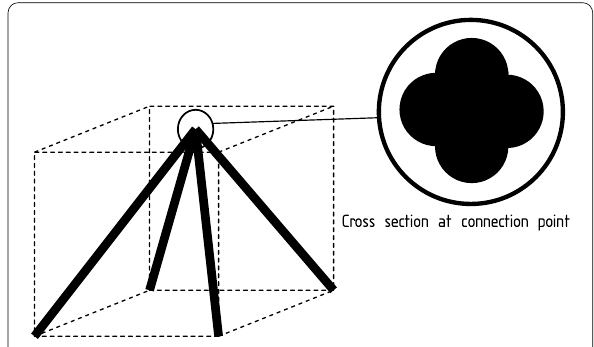
Figure 3 Non‑circular connection between face‑sheets and lattice 0.34mm core structure: A c ≈